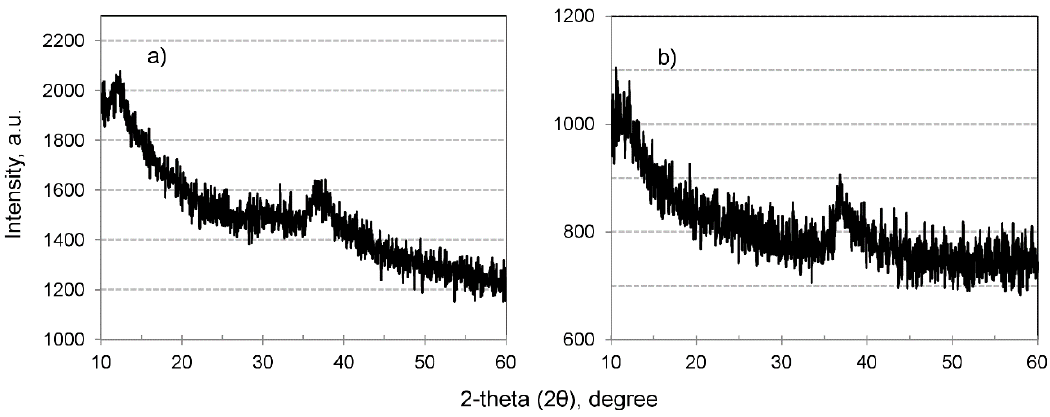
Figure 4. XRD patterns of hybrid material: ( a ) CWM1#MnO 2 , ( b ) CWM3#MnO 2.